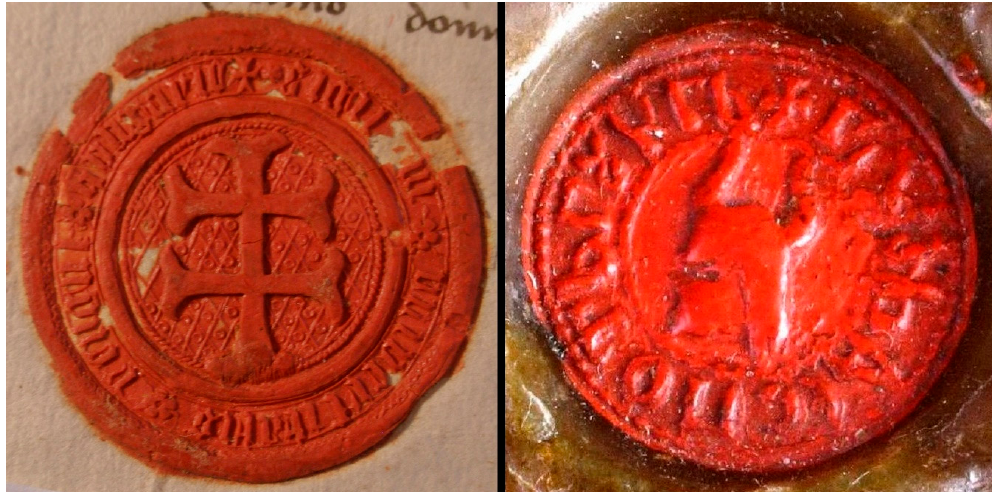
Figure 4. The seal of the national council from 1446 ( left side ). Archiv mesta Košice, Archivum Secretum ”B” Privilegium, Nr. 32. The seal of Đ ura đ Brankovi ć , Serbian despot from 1439 ( right side ) MNL OL DL 2009, 39 290.